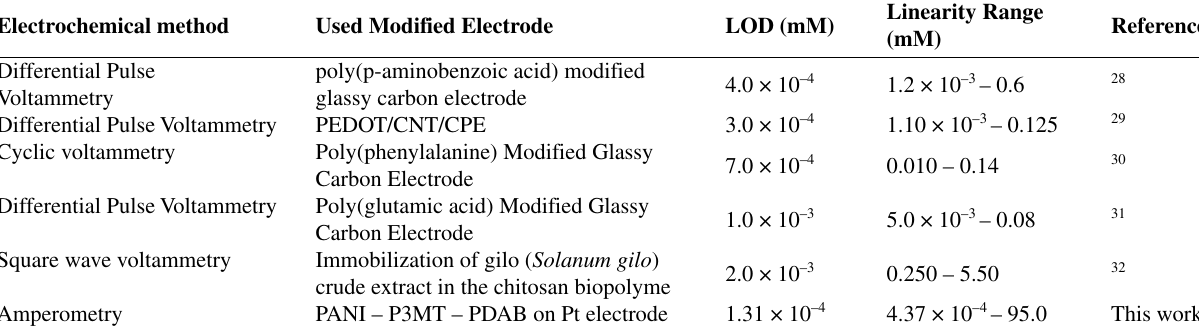
Table 4. Comparison of the improved method with the other modified electrodes for determination of HQ Electrochemical method Used Modified